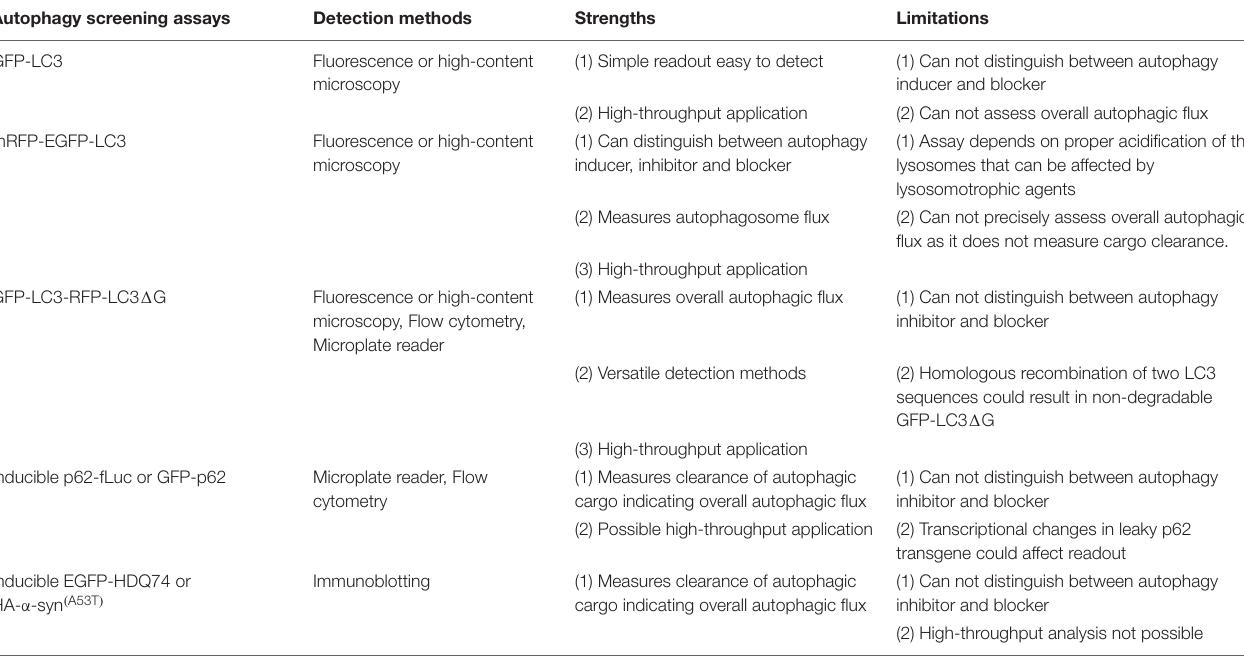
FIGURE 1 | Autophagy reporter and substrate based screening strategies and the impact of autophagy modulators at different stages of the autophagy process. Autophagy is regulated by the mechanistic target of rapamycin complex 1 (mTORC1) or mTORC1-independent pathways. This process initiates by the formation of phagophores that expand and engulf autophagy substrates to form autophagosomes, which then fuse with the lysosomes to form autolysosomes where the autophagic cargo is degraded. Autophagy inducers and inhibitors increase or decrease autophagosome formation, respectively, at the early stages of autophagy, whereas autophagy blockers prevent lysosomal degradation and/or autophagosome maturation at late stages of autophagy. Autophagic flux is thus enhanced by autophagy inducers but is retarded by autophagy inhibitors and blockers. Chemical screening methods for identifying autophagy modulators are commonly based on the readouts of perturbations in autophagy reporters such as LC3-II, or autophagy substrate clearance such as aggregation-prone proteins or p62/SQSTM1. TABLE 1 | Chemical screening methods for identifying autophagy modulators in mammalian